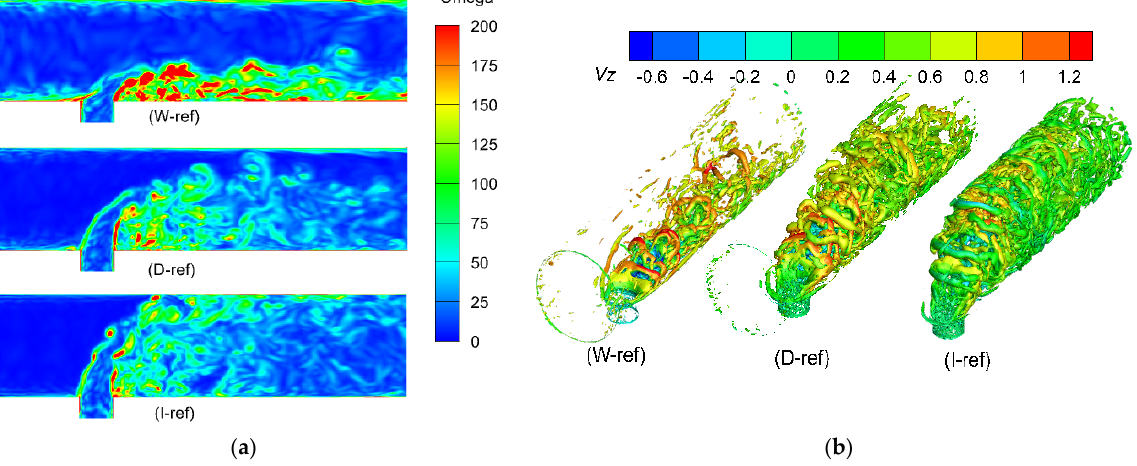
Figure 5. Contours of turbulence generation and structure in three cases: ( a ) Vorticity contours, ( b ) Q -criterion colored with V z in the cases.